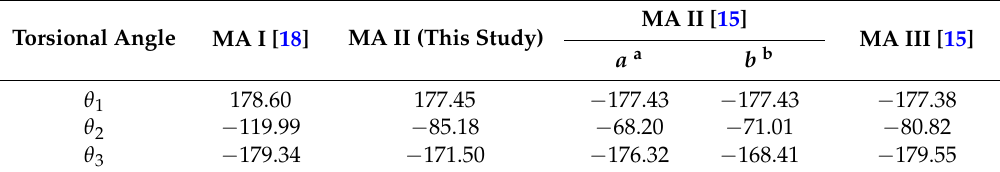
Figure 4. Space-filling diagrams for ( A ) Form I; ( B ) Form II; ( C ) Form III. Table 3. Comparison of torsional angles between Forms I and II of MA.